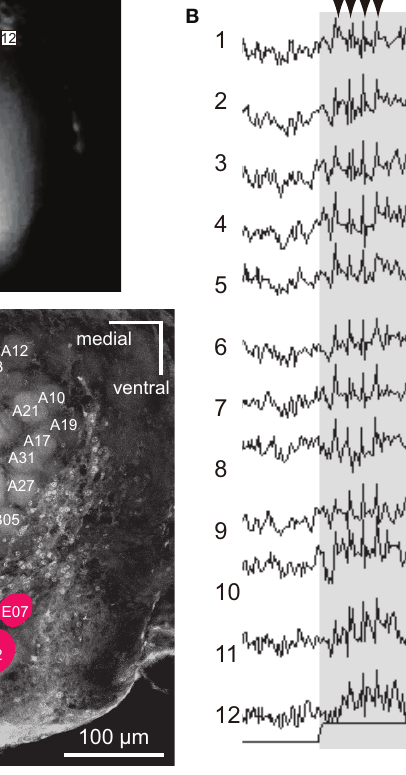
FIGURE 5 | The spatio-temporal patterns of synchronized potentials induced by enanthic acid. (A) A VSD image of the cockroach AL. The enanthic acid-induced depolarizing potentials were observed in nine pixels (numbers 1–9) located in the postero-ventral region of the AL and three pixels (numbers 10–12) located in the dorsal soma cluster of secondary olfactory interneurons. (B) The enanthic acid-induced synchronized potentials evoked in 12 pixels shown in (A) . Enanthic acid (shaded area) induced phasic on-response of synchronized potentials. The changes of membrane potentials